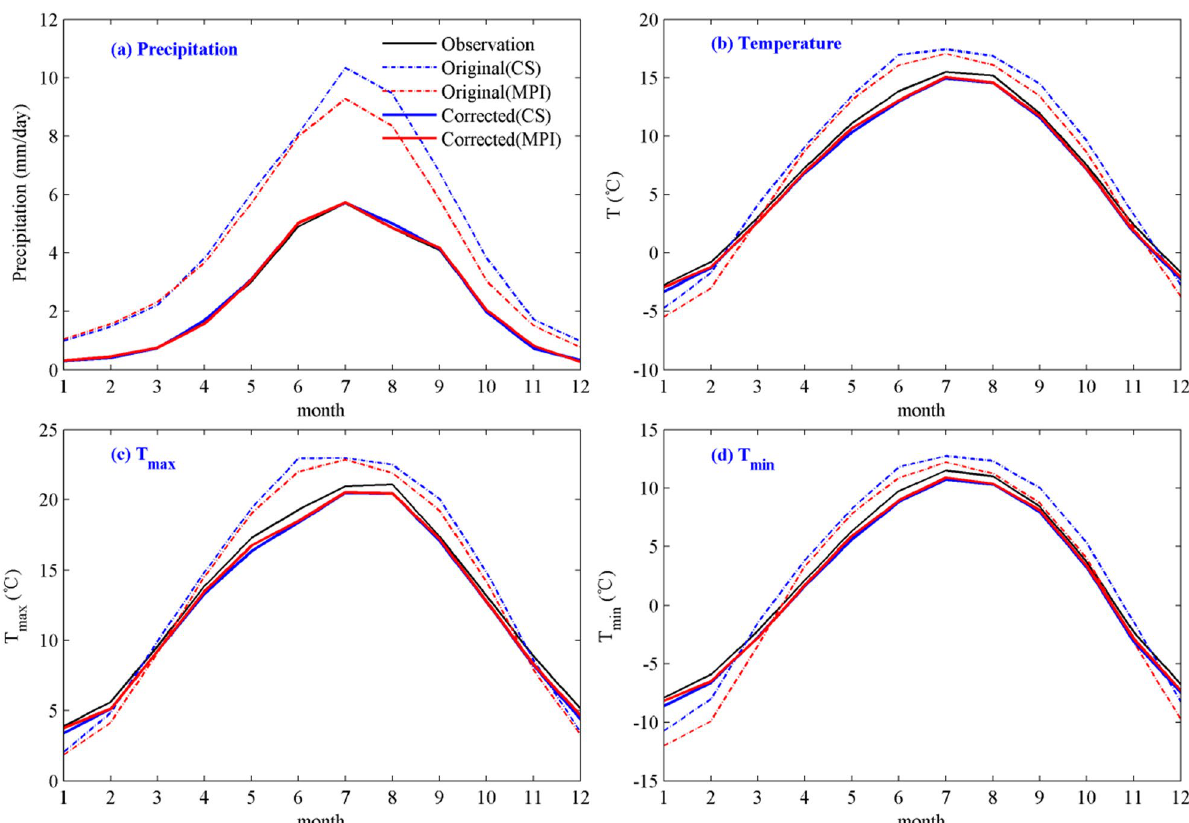
Figure 7. Annual cycles of precipitation (a) , T 2m (b) , T max (c) and T min (d) before and after the revision from R_CS and R_MPI. (The black line represents the observation; the blue and red dashed lines represent the result before the R_CS and R_MPI corrections, respectively; the blue and red lines represent the result after the R_CS and R_MPI corrections, respectively). The figure was generated by MATLAB2019a (https:// www. mathw orks.